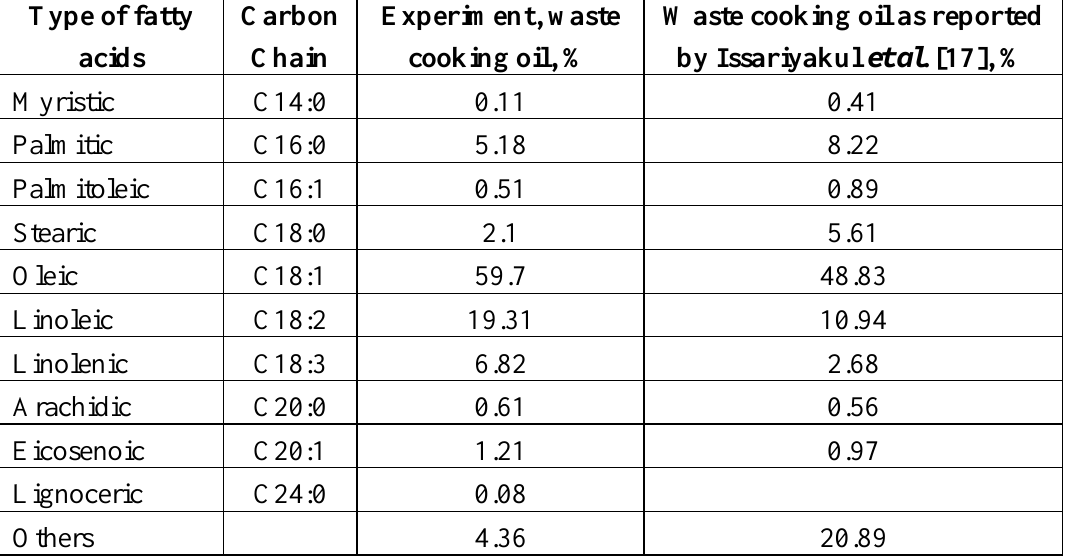
Table 2. Fatty acid composition of biodiesel from waste cooking